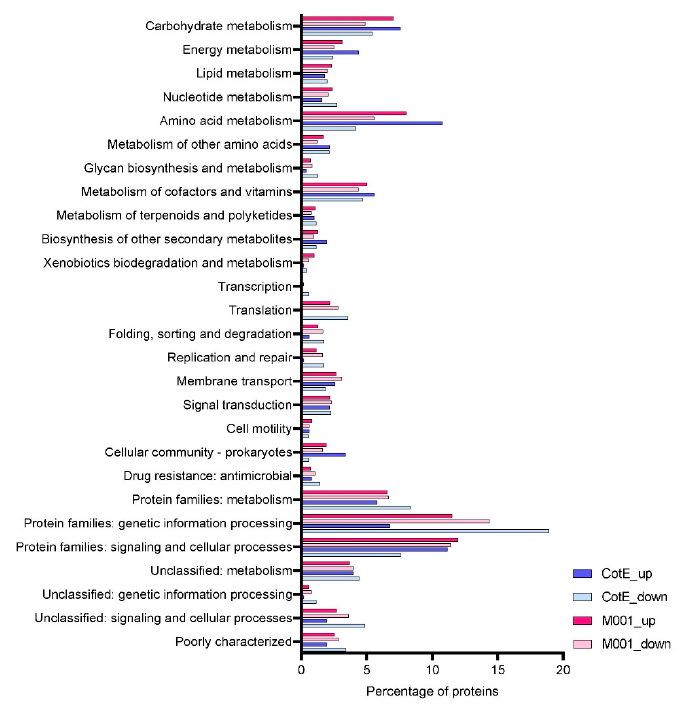
Figure 3. The KEGG functional enrichment of differentially expressed proteins in spores of strains cotE and M001 compared with WT spores. cotE and M001 compared with WT